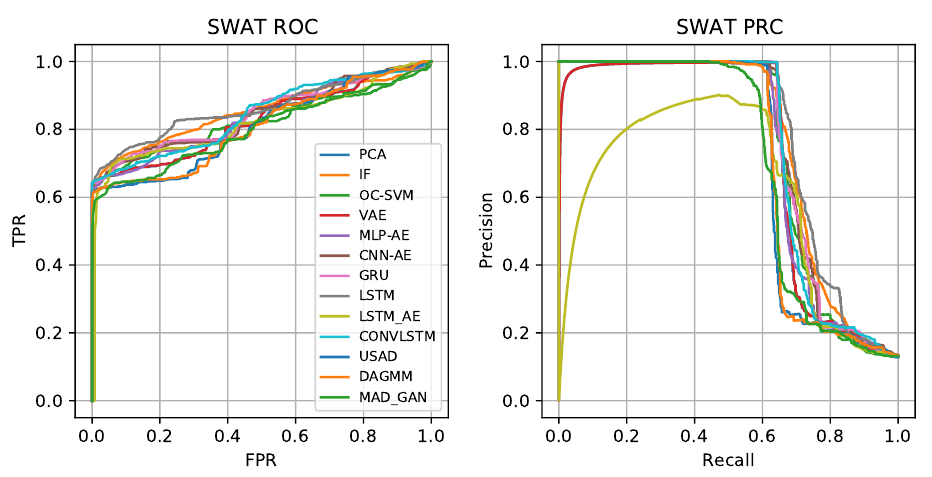
Figure 4. ROC and PRC for SWaT